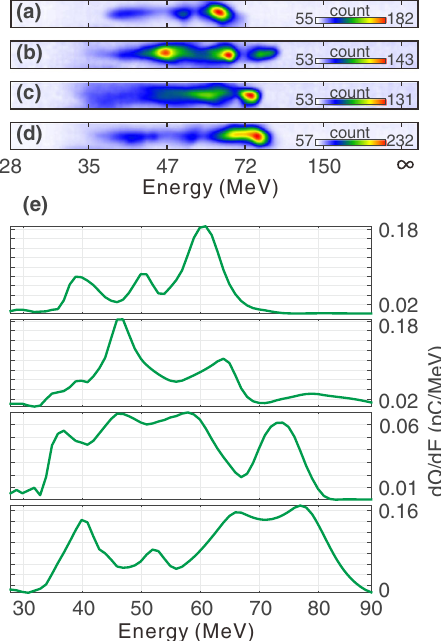
FIG. 5. (a) – (d) are the raw experimental spectra as seen on the Lanex screen. The color bars represent for the charge density. The corresponding linearized energy spectrums are shown in (e). The plasma density for these shots is 1 . 26 (cid:2) 0 . 11 × 10 19 cm − 3 .